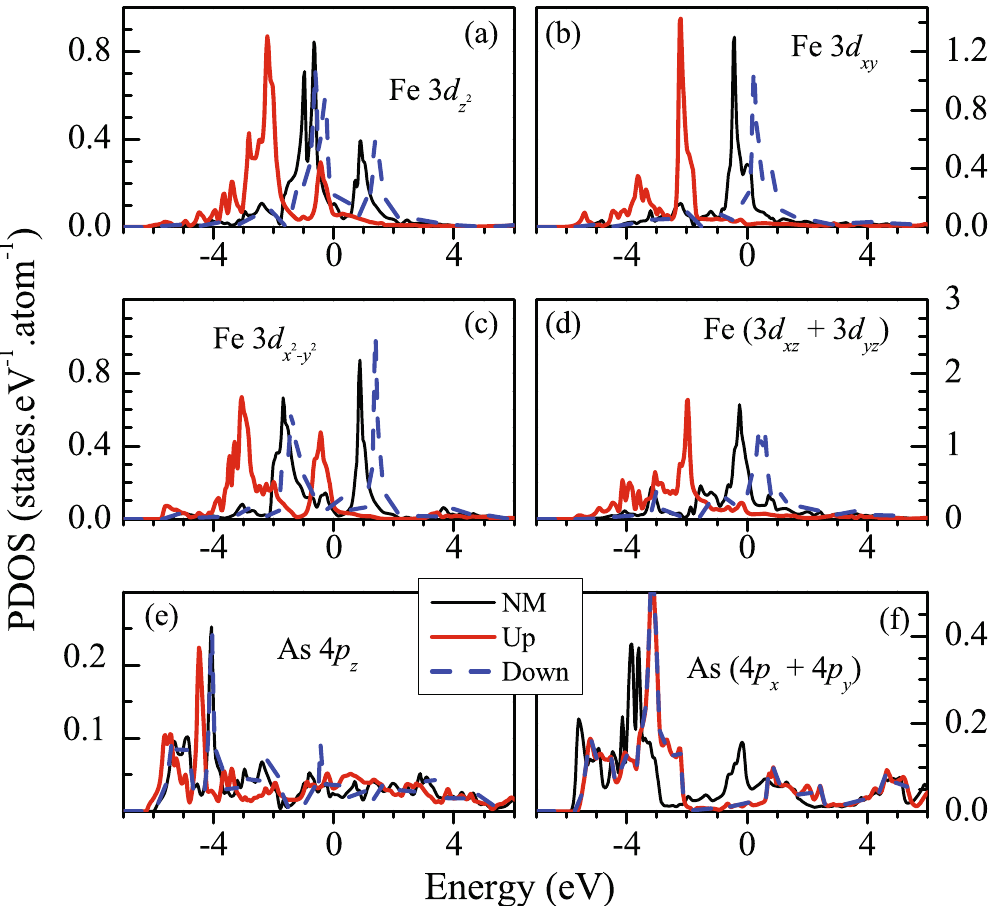
Figure 8. Comparison of the partial Density of states of different d orbitals calculated for magnetic and non Magnetic (NM) configurations for tetragonal structure. The details of the d symmetries are defined as legends in each block of the plots. NM PDOS, and Up & Down spin PDOS are denoted by thin solid line, thick solid line and dashed line,